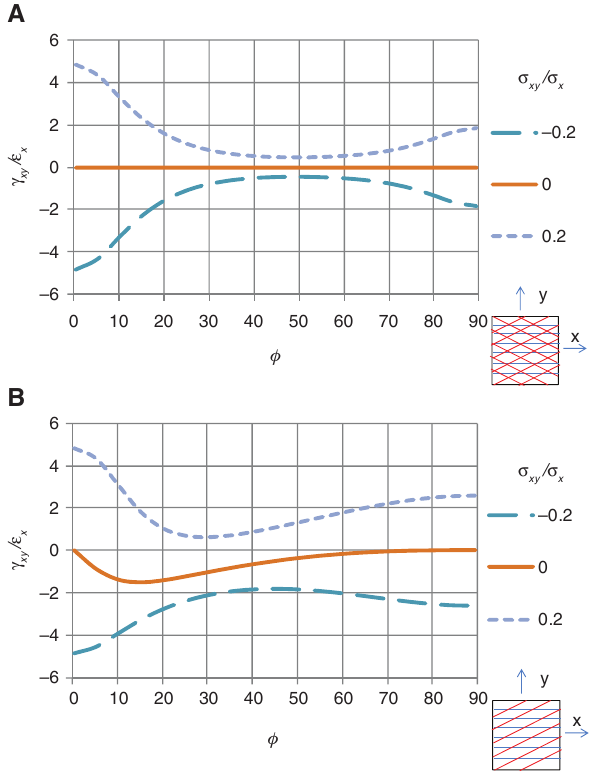
: in-plane shear strain component and ε Figure 5: Ratio of γ xy extensional (on-axis) strain component as a result of applied shear-normal stresses.